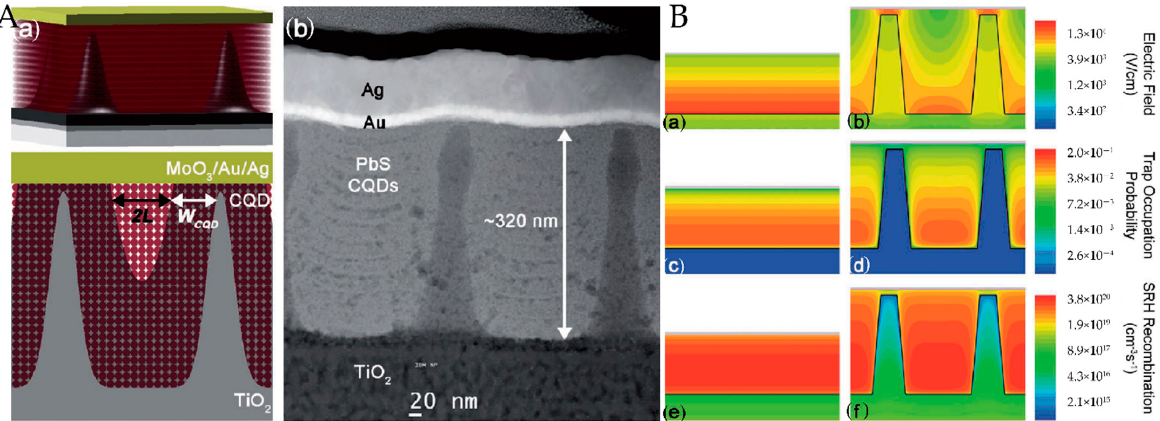
Figure 7. ( A ) ( a ) Schematic and ( b ) SEM images of CQDSCs; ( B ) electric field distributions, trap occupation, and SRH recombination of planar and nanopillar architectures [96].